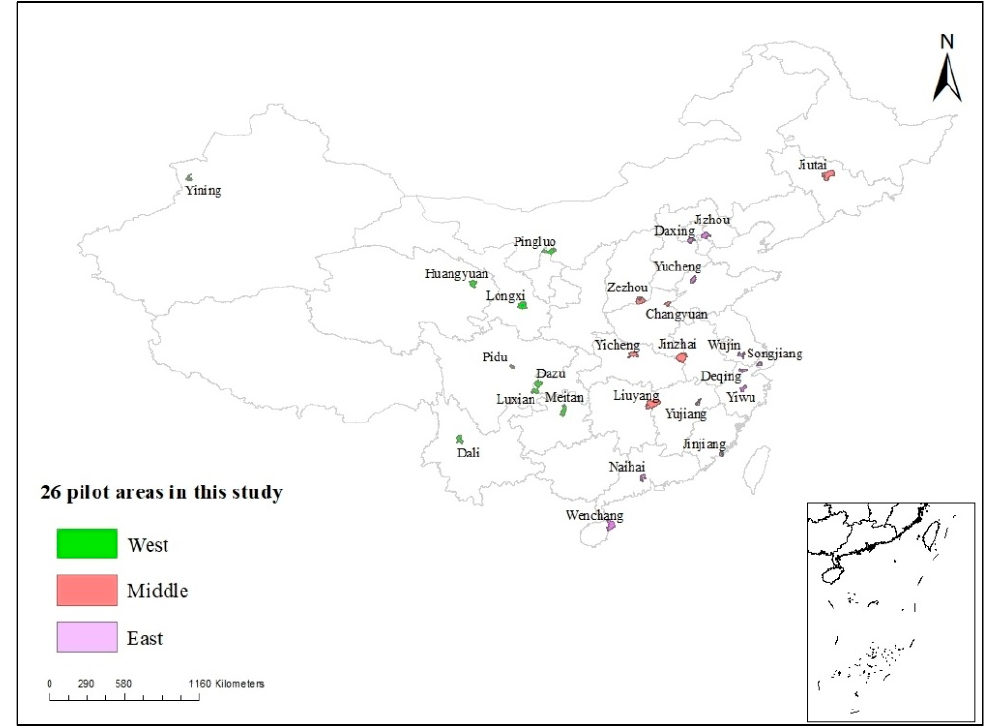
Figure 1. Spatial distribution of the 26 pilot areas.